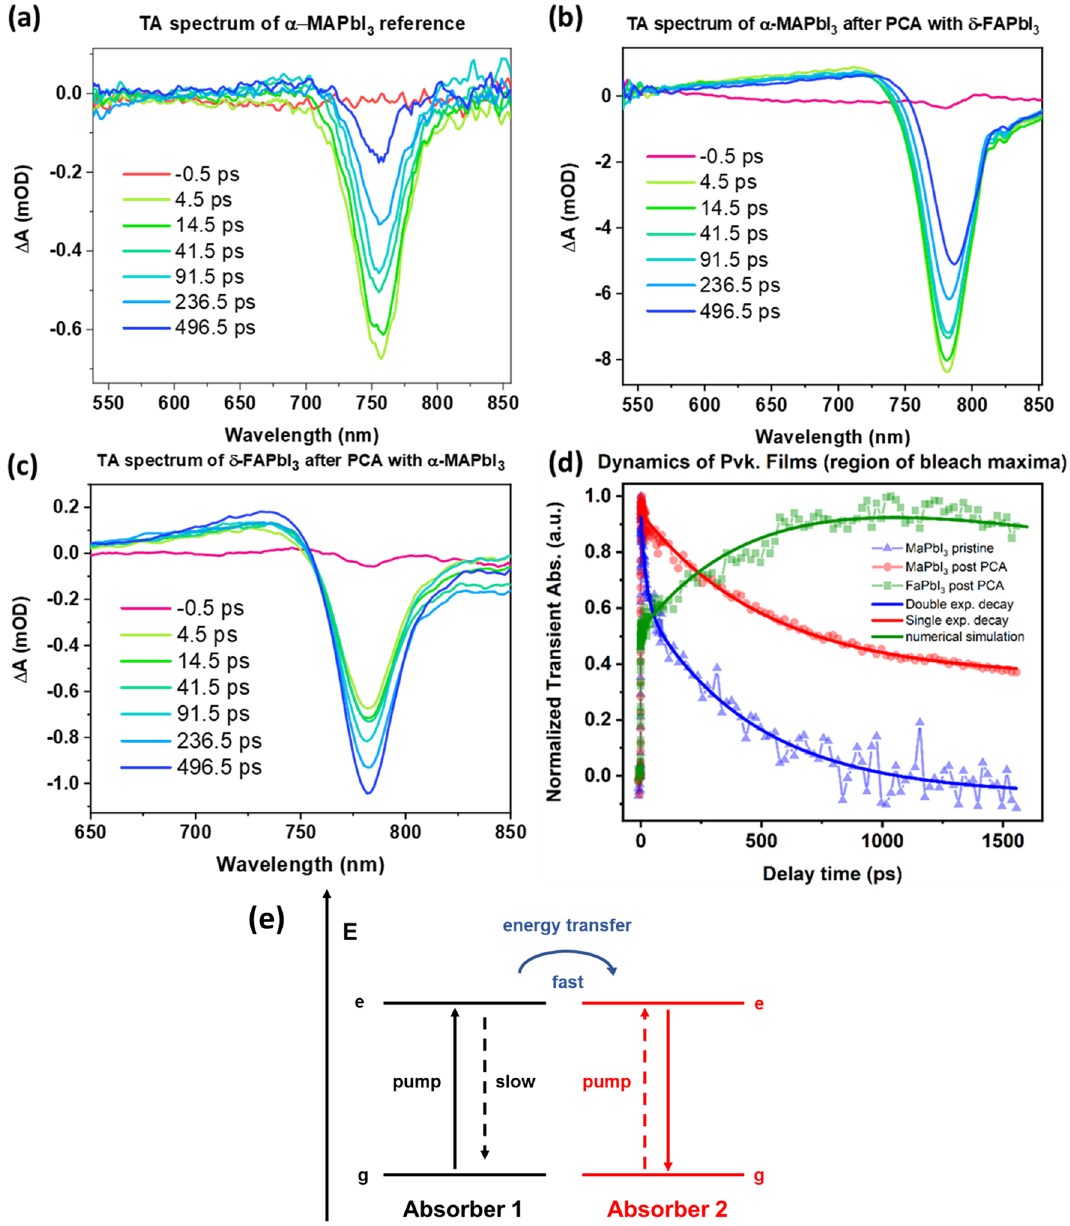
α-MAPbI 3 and post-PCA MAPbI 3 , whereas the post-PCA FAPbI 3 data were fitted with a numerical simulation. ( e ) Hypothesized energy level diagram for the post-PCA FAPbI 3